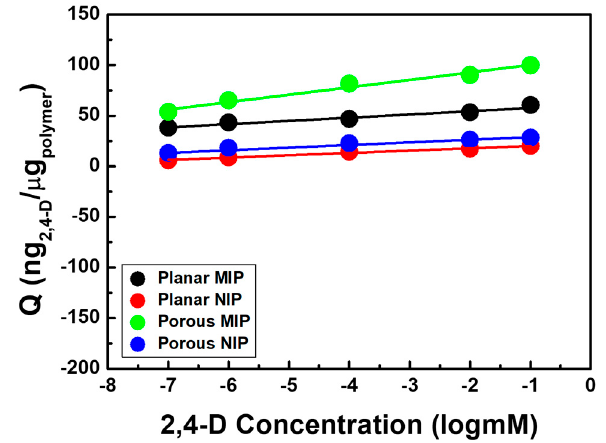
Figure 4. Q values (adsorbed 2,4-D mass (ng) per poly(MAA-co-EGDMA) unit weight (µg)) on the p -MIP/NIP and pl -MIP/NIP films as a logarithm function of 2,4-D’s concentration, and the concentration of 2,4-D ranges from 10 − 7 to 10 − 1 mM ( n = 3).